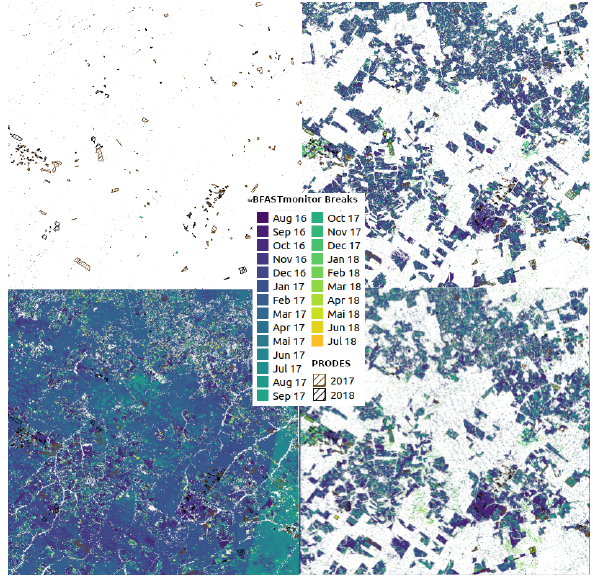
Figure 2. PRODES and BFAST monitor breaks with indices NDVI (top-left), GEMI (top-right), EVI (bottom-left) and SAVI (bottom-right) at tile 21LYH from August 2016 to July